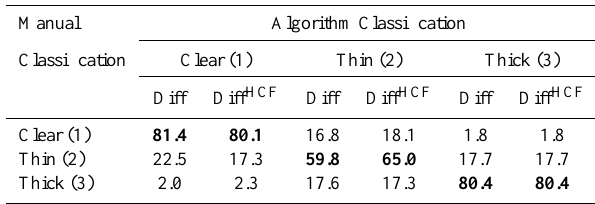
Table 2. Confusion matrix for CDOC of training set based on the Diff and Diff HCF metric (Eq. 5, 6 respectively) All values are in [%].